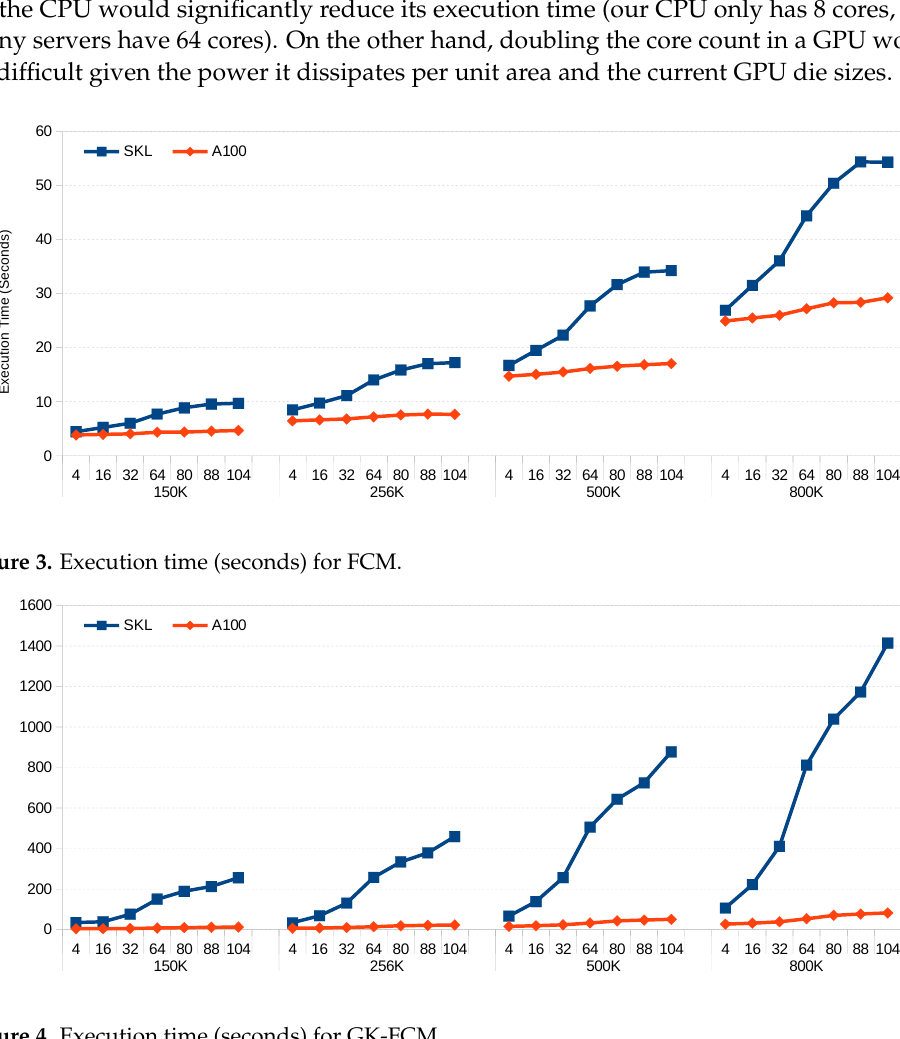
Figure 4. Execution time (seconds) for